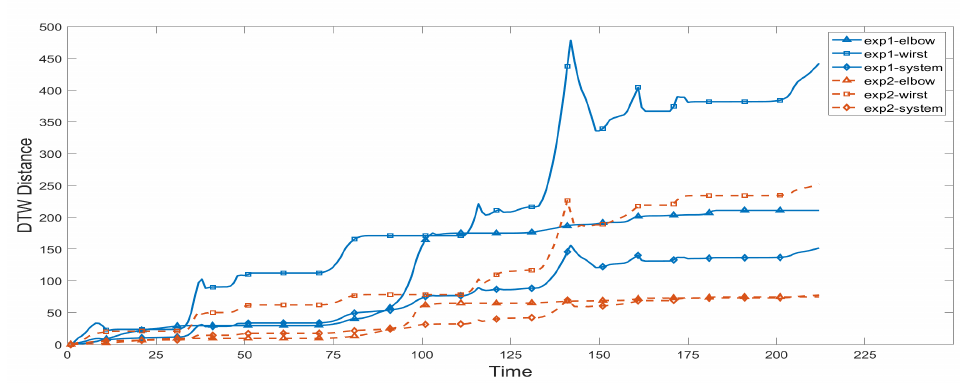
Figure 15. DTW distance in the